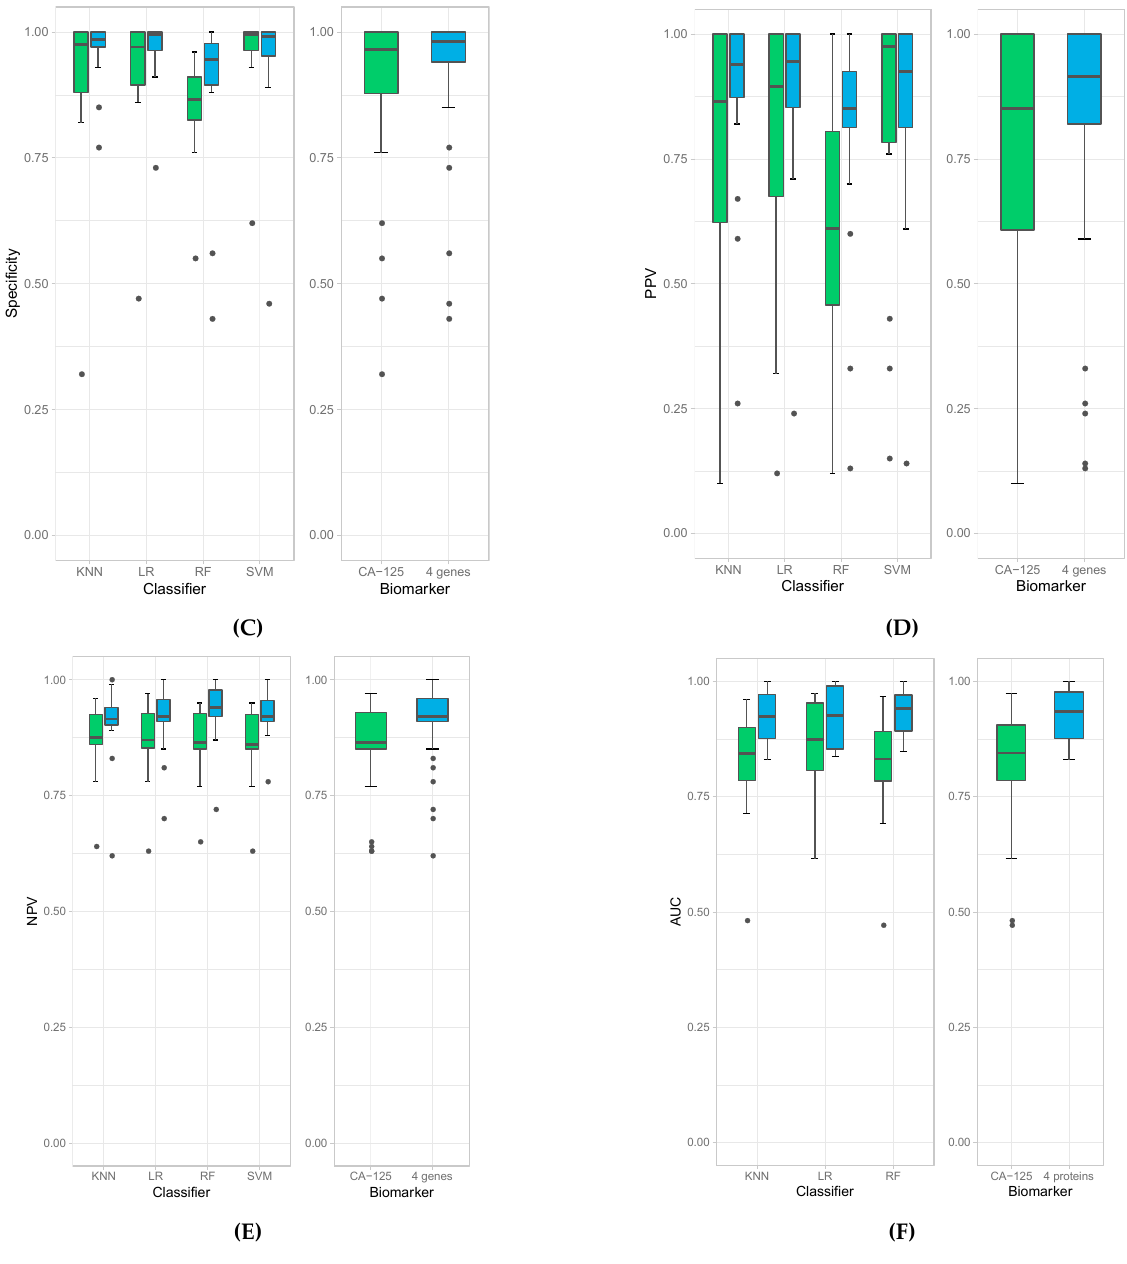
Figure 1. Box plots of accuracies ( A ), sensitivities ( B ), specificity ( C ), PPV ( D ), NPV ( E ), and AUC ( F ) obtained by individual classifiers (left panel), namely K-Nearest Neighbor (KNN), Logistic Regression (LR), Random Forest (RF), and Support Vector Machine (SVM), and average accuracies of all models (right panel) when using CA-125 alone (green bars) and using all four genes (blue bars).